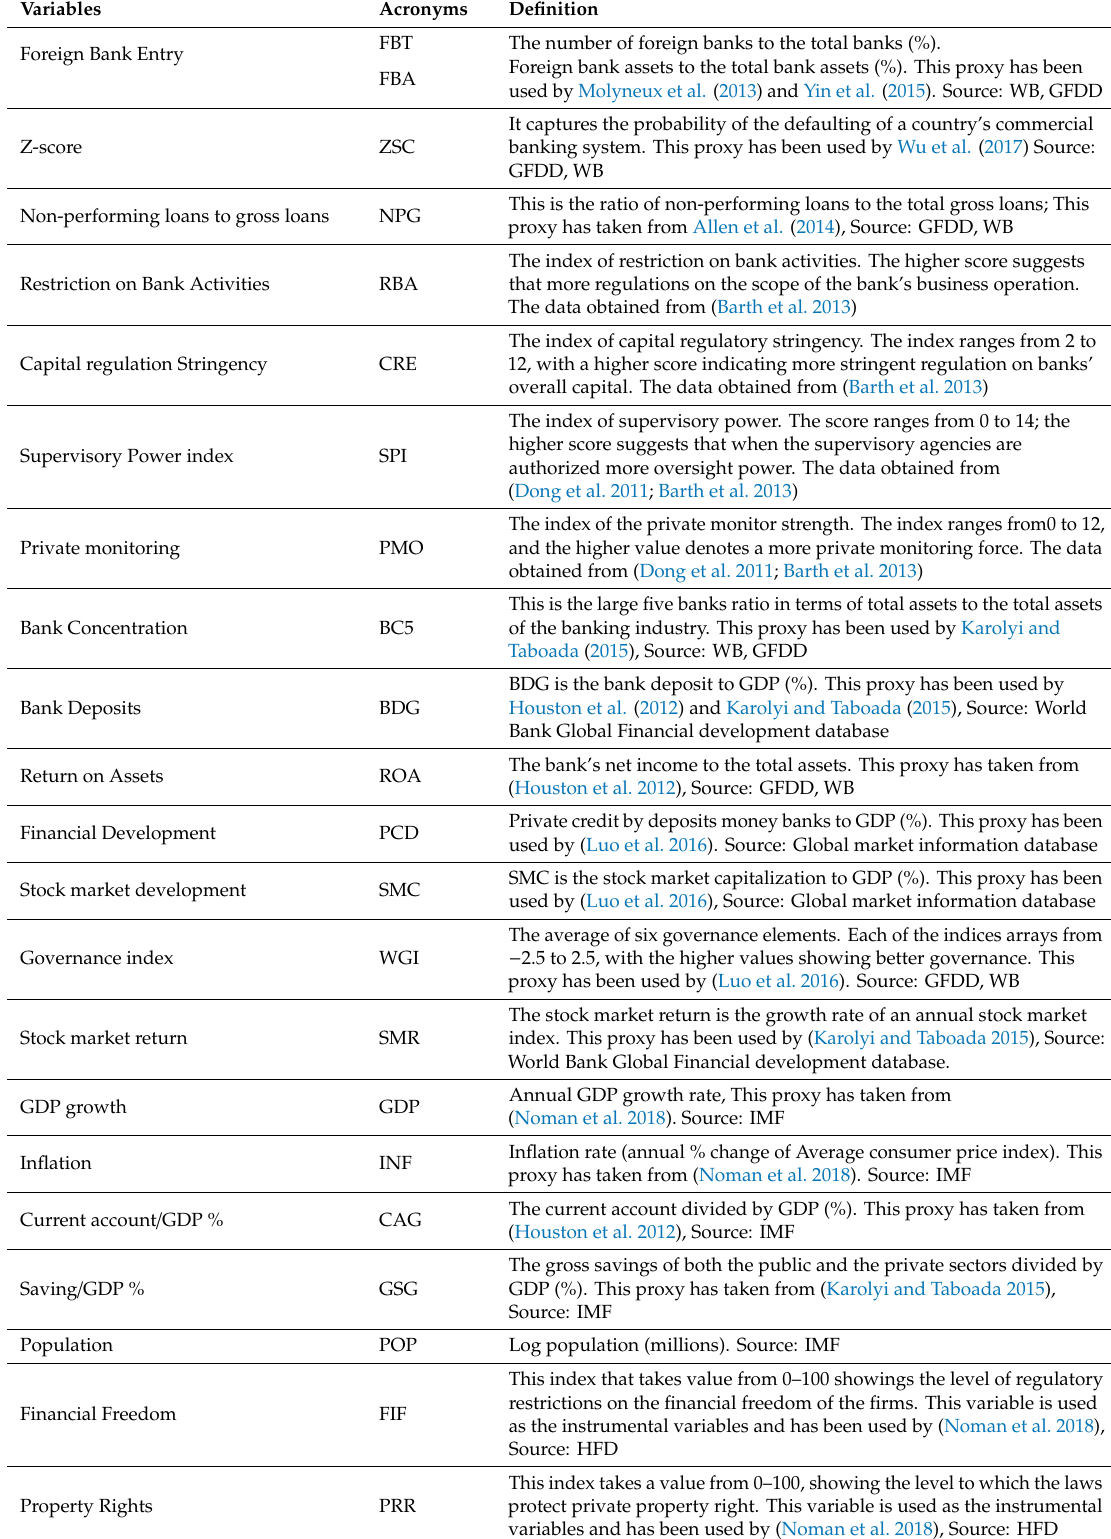
Table A1. Definition of variables, data sources, and